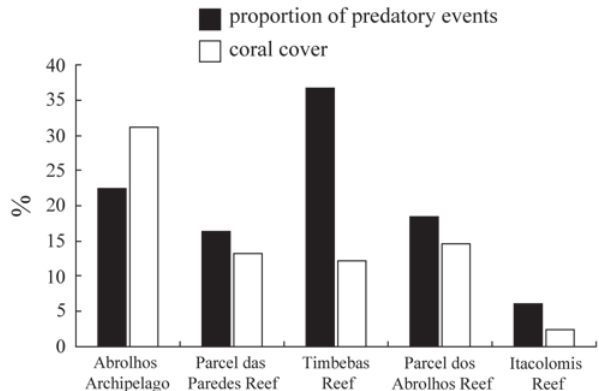
Fig. 2. Proportion of opportunistic records of coral predation by Scarus trispinosus and Sparisoma amplum and coral cover at five sites at the Abrolhos